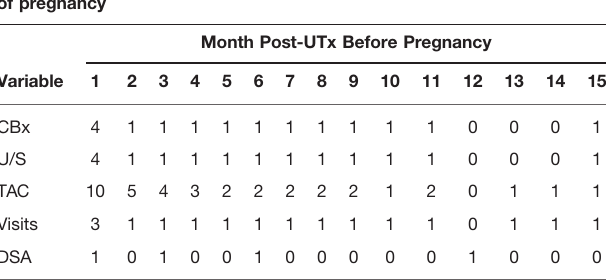
Table 1B Timeline for patient management during gestation Variable